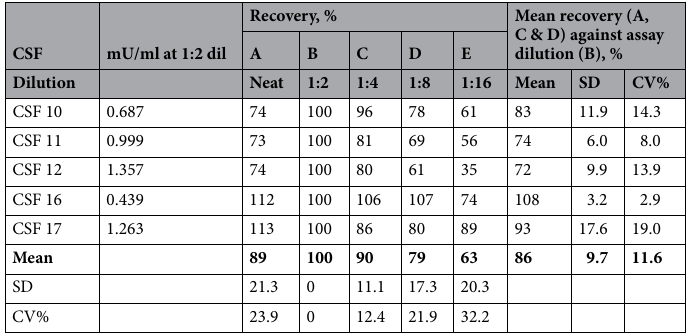
Table 1. Parallelism of five different CSF samples.